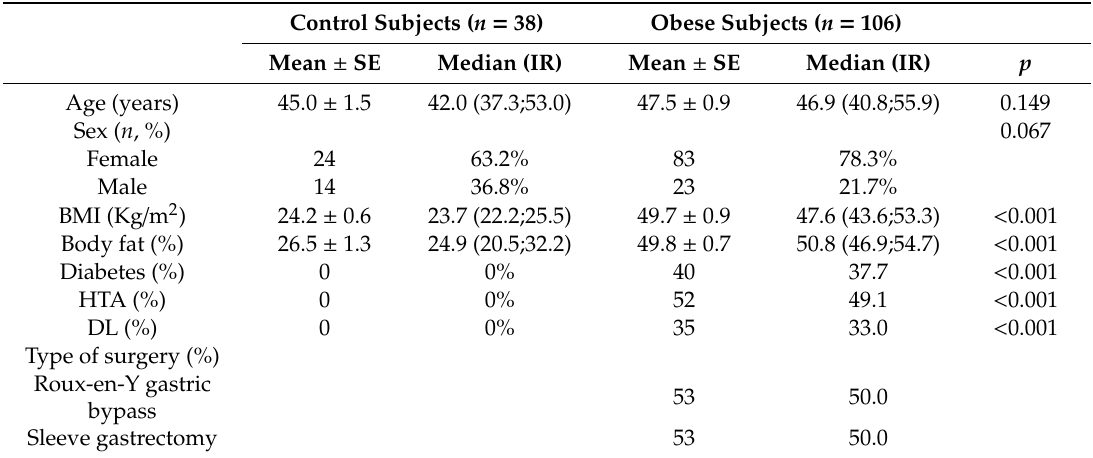
Table 1. Preoperative characteristic of the obese patients and the control subjects, (Mean ± SE; median, interquartile